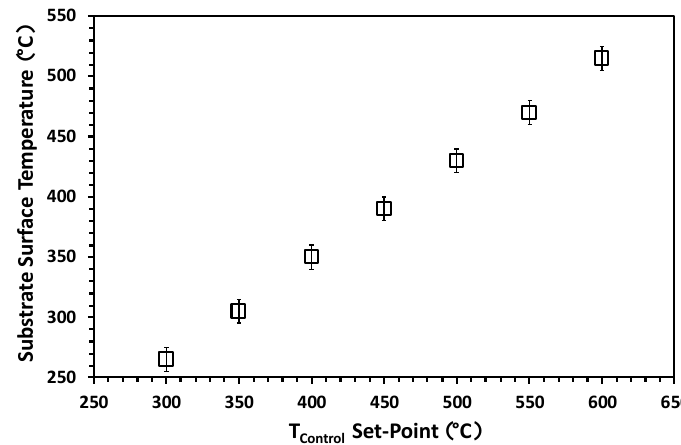
Figure 3. Controller temperature set-point vs averaged measured substrate surface temperature.